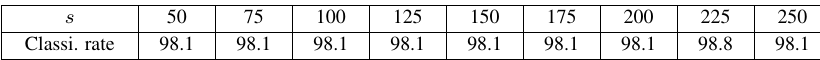
Table 3. Classification rates with respect to s